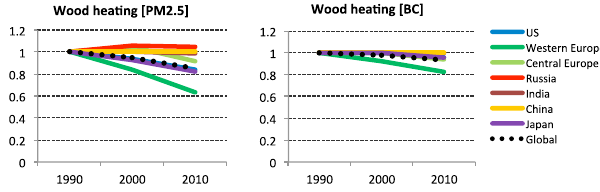
Figure 1. Change in implied PM 2 . 5 and BC emission factors for residential wood heating in selected countries and world regions; changes relative to 1990 in ECLIPSE V5a dataset.